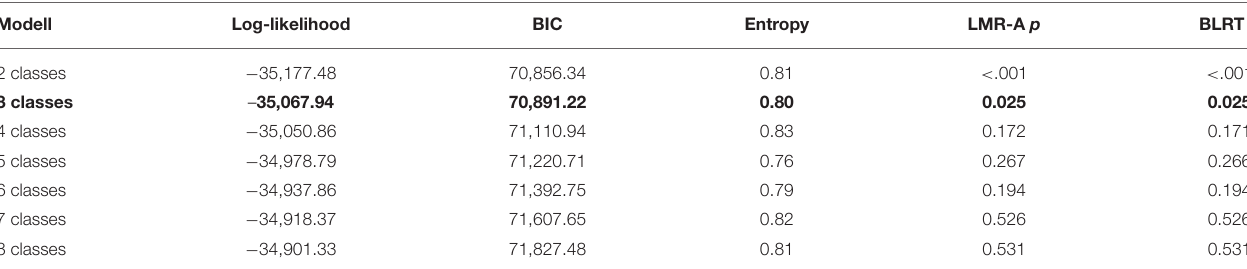
TABLE 1 | Fit indices for the seven different latent profile analyses.